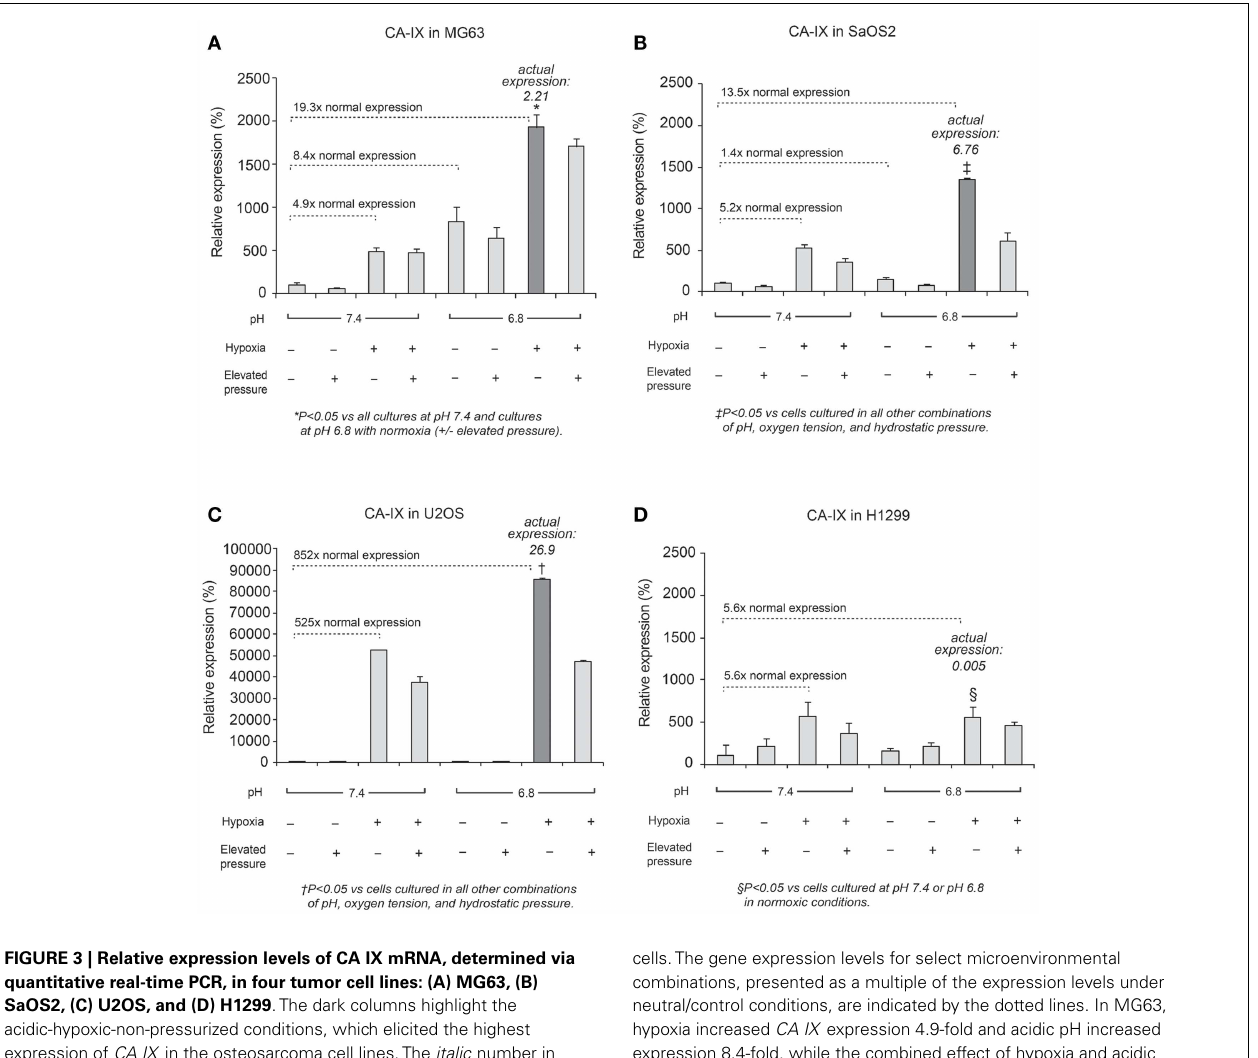
cells.The gene expression levels for select microenvironmental combinations, presented as a multiple of the expression levels under neutral/control conditions, are indicated by the dotted lines. In MG63, hypoxia increased CA IX expression 4.9-fold and acidic pH increased expression 8.4-fold, while the combined effect of hypoxia and acidic conditions elevated CA IX expression by a factor of 19.3. Hypoxia and acidic conditions elevated CA IX expression 852-fold in U2OS and 13.5-fold in SaOS2, while combined conditions did not promote increased CA IX expression in